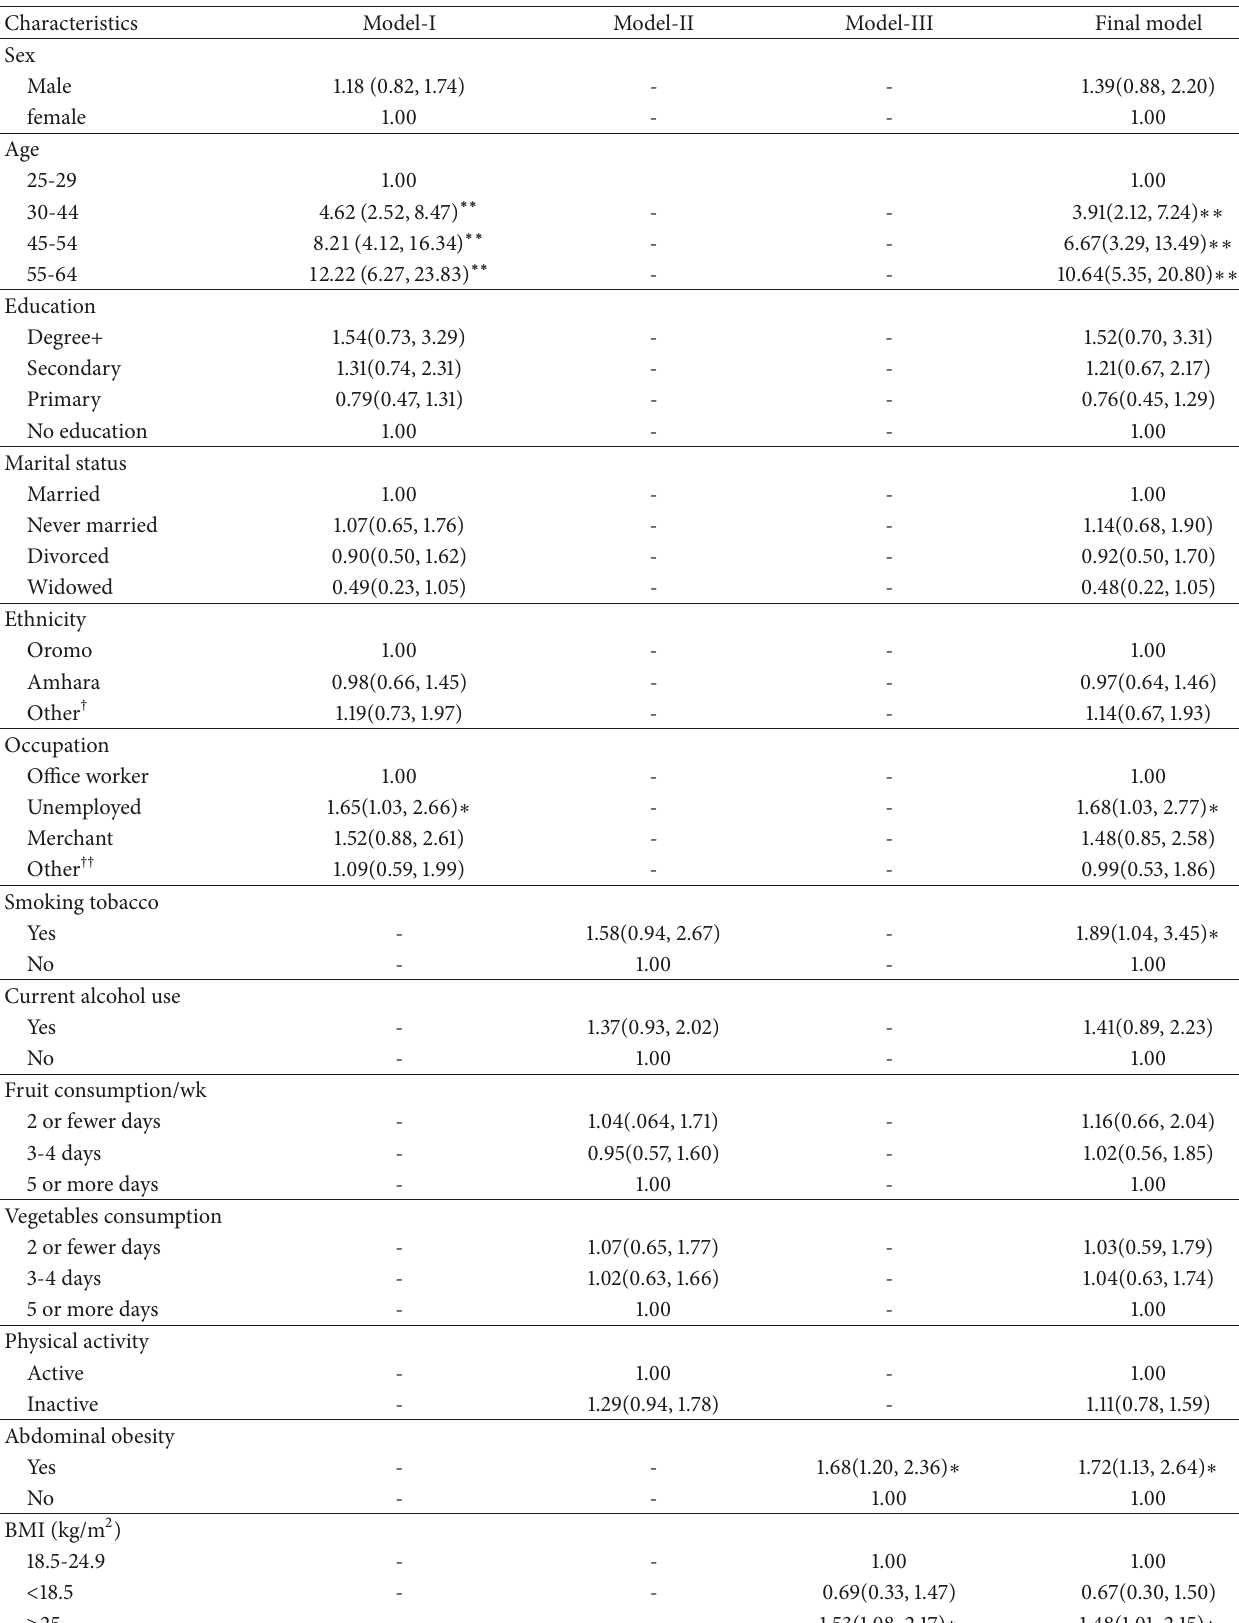
Table 3: Factors associated with hypertension in Dire Dawa City Administration,